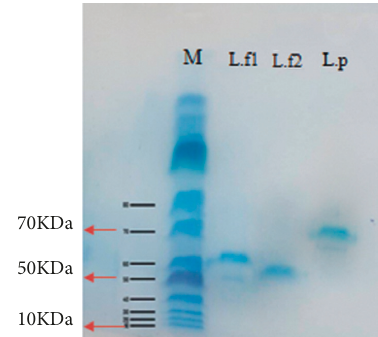
Figure 2: Bacteriocins isolated from two strains of Lactobacillus fermentum (L.f1 and L.f2) with a molecular weight of 60 and 58kd, respectively, and bacteriocins isolated from (L.p) Lactobacillus plantarum with a molecular weight of 70kd using SDS-PAGE electrophoresis.